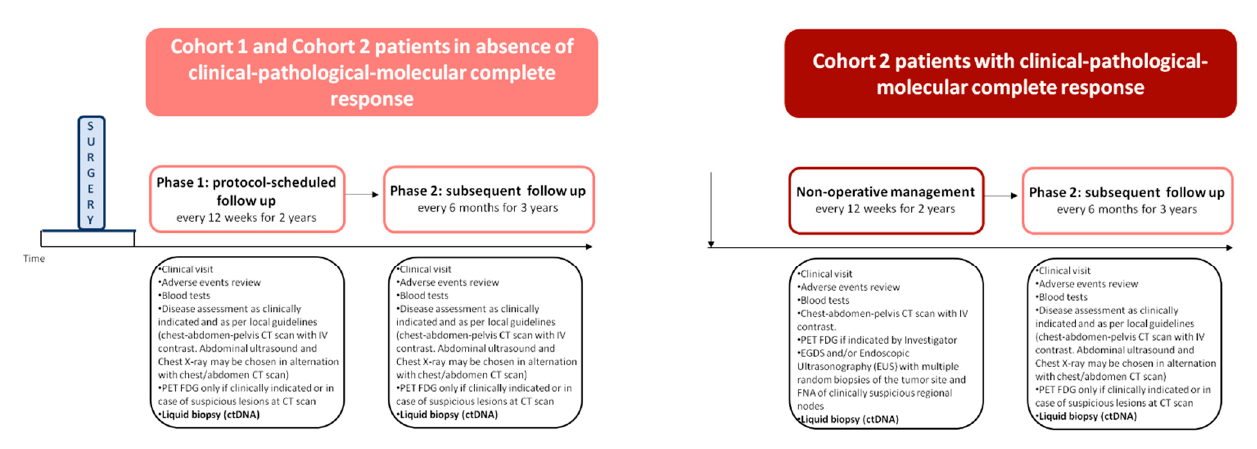
Figure 1. This figure illustrates the INFINITY study design.